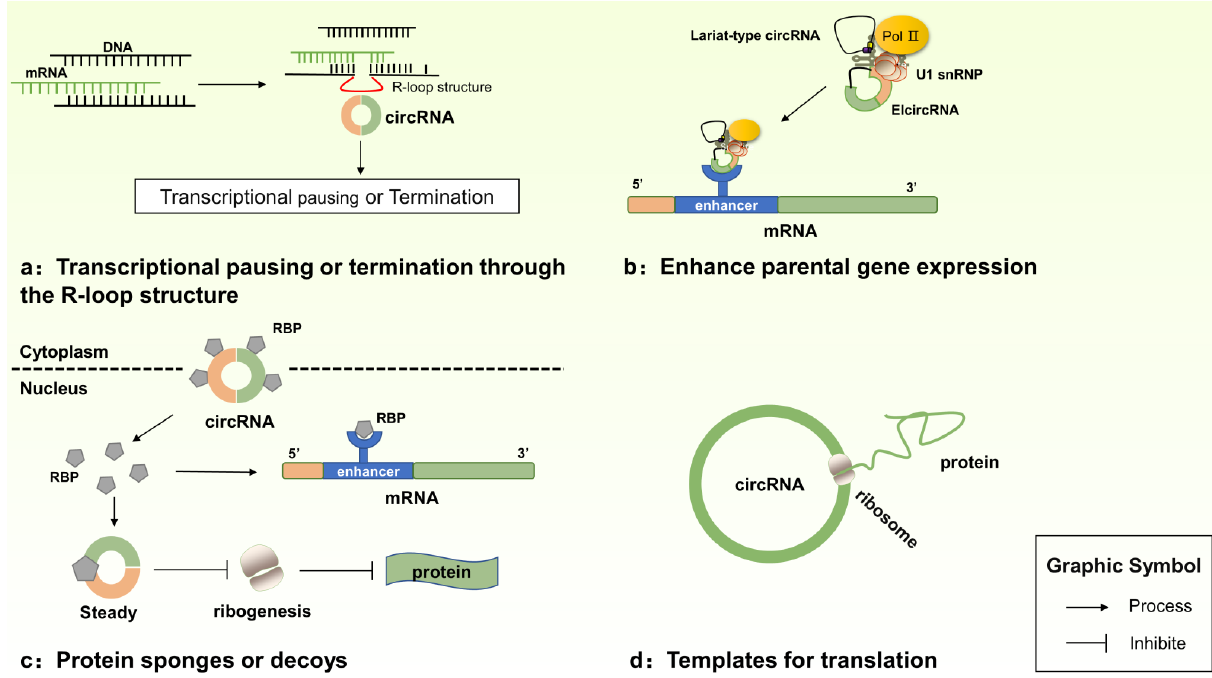
Figure 2. The other functions of circRNAs. ( a ) Transcriptional pausing or termination through the R-loop structure; ( b ) enhance parental gene expression; ( c ) protein sponges or decoys; ( d ) templates for translation. Abbreviations: U1 snRNP (U1 small nuclear ribonucleoprotein), RBP (RNA-binding proteins).